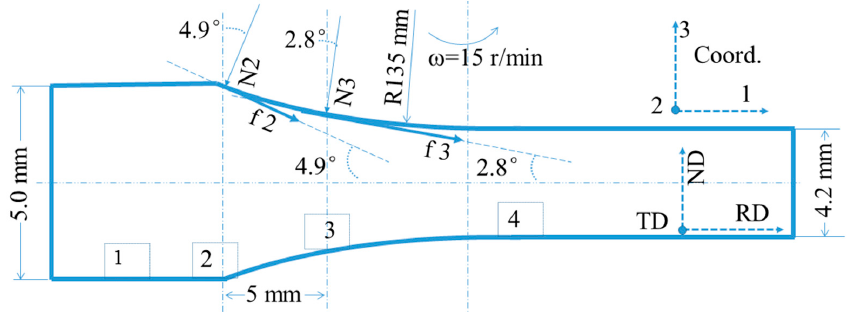
Figure 1. Shape of the sample section and the locations for detection as denoted by numbers 1–4 in the square set correspond to the locations for detection.